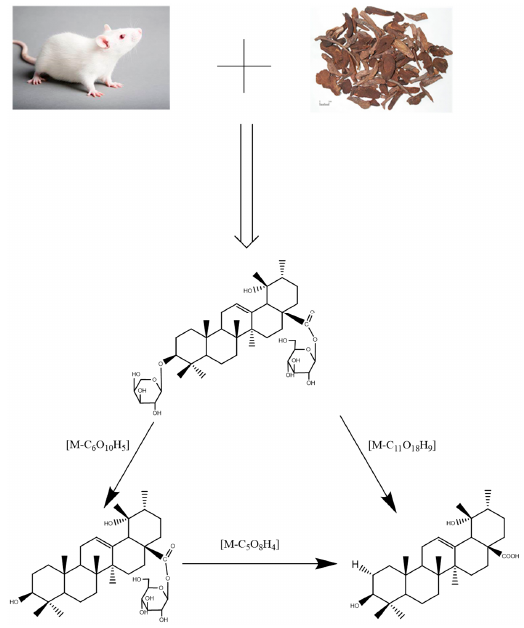
Figure 5. Proposed metabolic pathways of ZGI, DGE, and PA in rats.